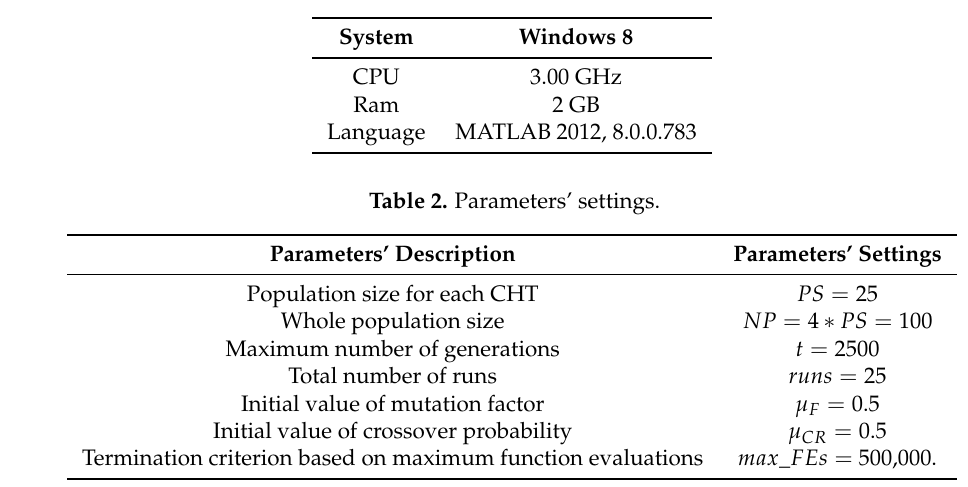
Table 1. Configuration of the PC.